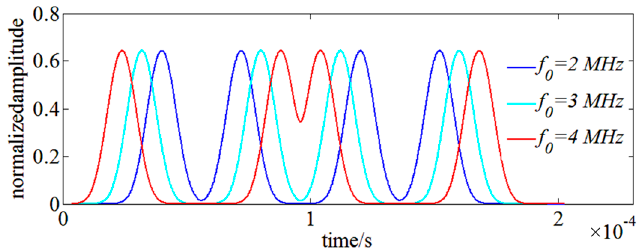
Figure 3. The relationship between overlapping of double monochromatic signals with the center frequency f 0 of RBW filter.